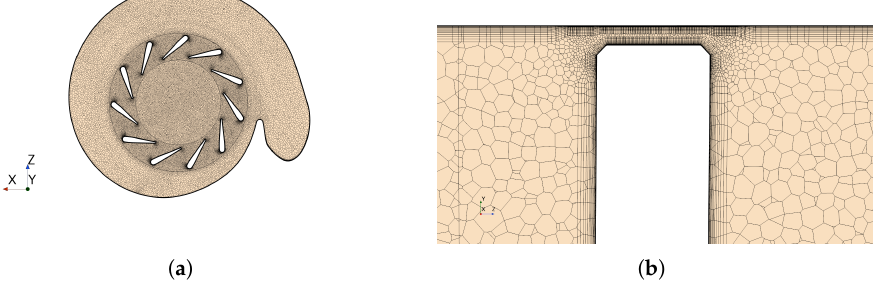
Figure 2. Polyhedral unstructured mesh with refinements near walls. ( a ) Mesh upper view. ( b ) Prism layer meshing surrounding vanes.